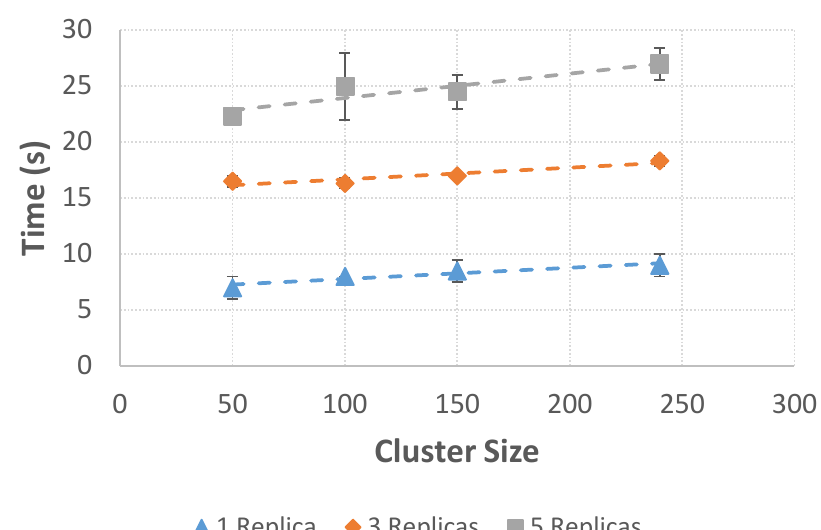
Fig. 3. Sustained rate of the pause container deployment for different values of the QPS parameter set. With QPS values four times higher than the Kubernetes default configuration, a sustained rate of 70 containers per second is reached. Fig. 4. Time to fully populate the cluster with pause containers as a function of the cluster size and for different number of replicas on each host. QPS values are set to four times the default Kubernetes configuration. Extrapolating the results for one replica to a cluster of 3000 nodes, the cluster itself would be fully populated in about 35 seconds